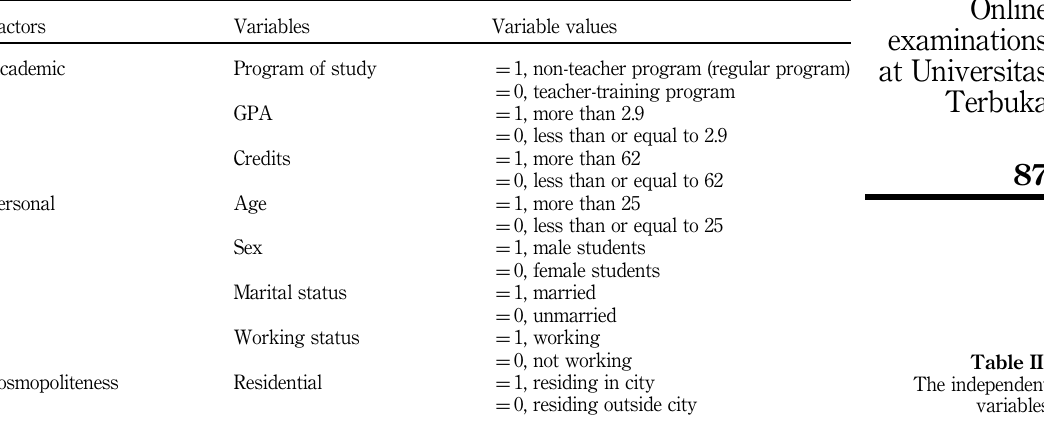
Table II. The independent